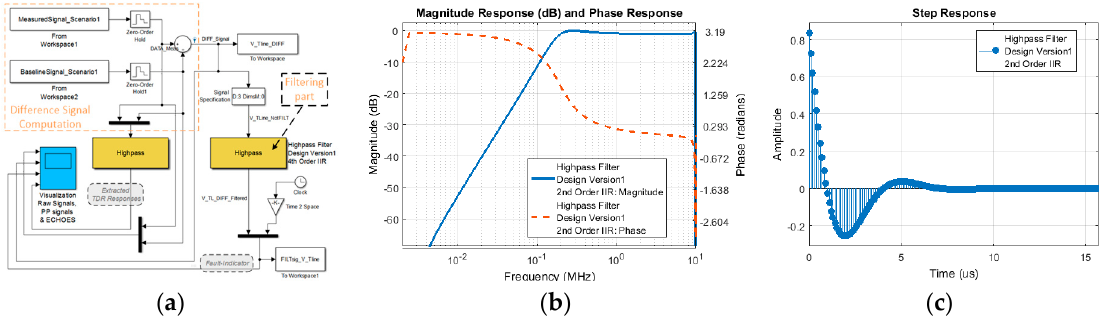
Figure 9. Data post-processing procedure implementation: ( a ) MATLAB/Simulink block scheme, ( b ) high-pass filter frequency response, and ( c ) impulse response.